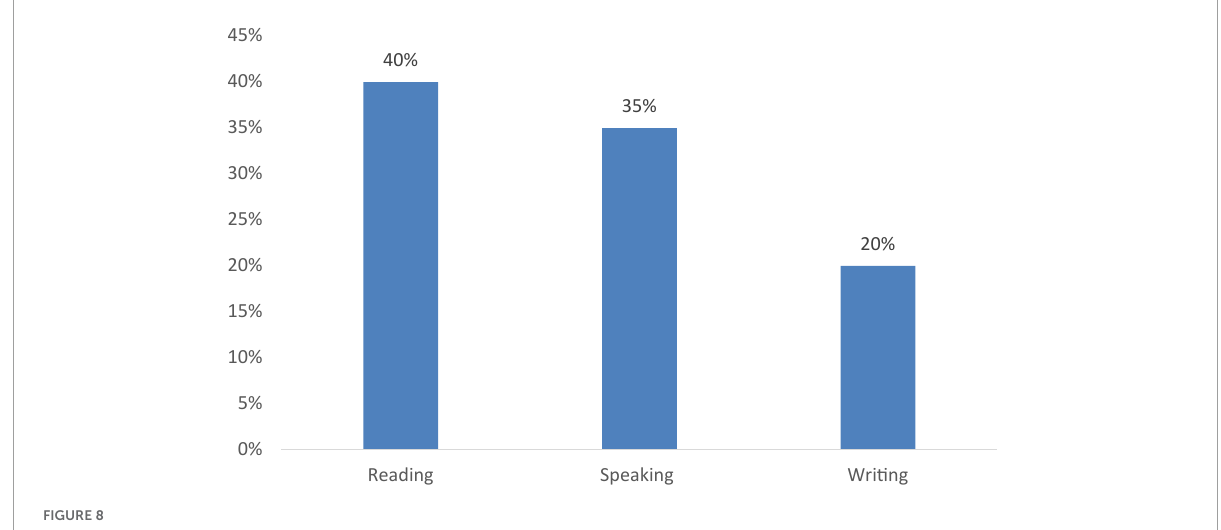
FIGURE8 Elevate language training categories with the highest score, group 1 (author’s data).